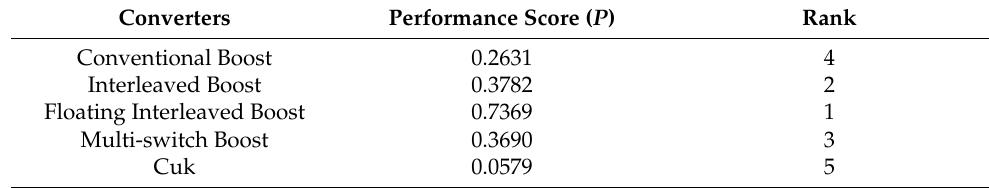
Table 4. The determined performance scores and ranks for the candidates (second scenario).